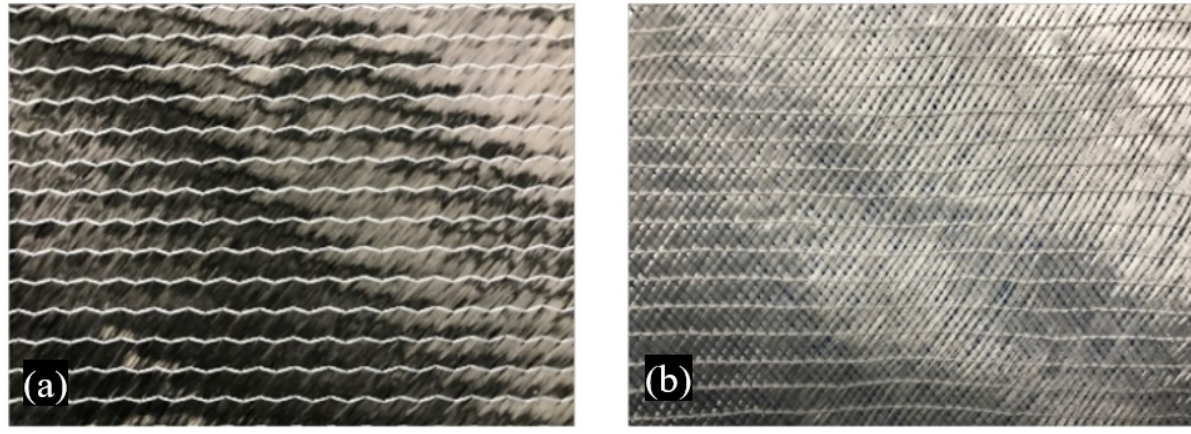
Figure 4. BX45° NCF fabrics: ( a ) carbon (Chomarat Co., Ltd., Le Cheylard, France) and ( b ) glass (HANKUK Carbon Co., Ltd., Seoul, Korea).